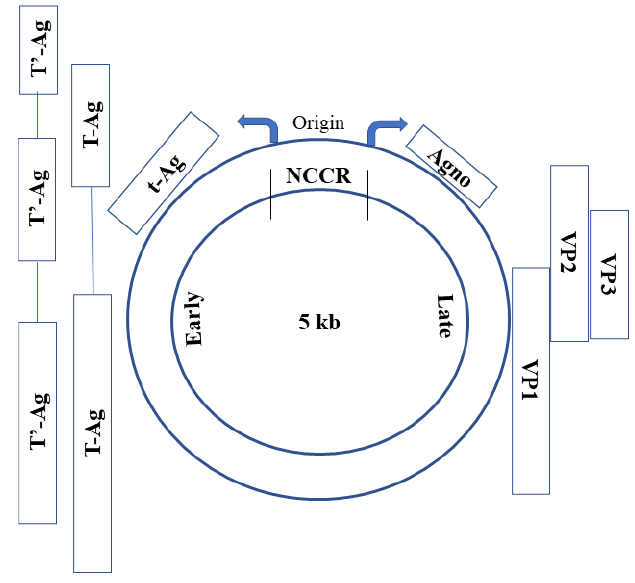
Figure 1. Graphical Sketch of BKV Genome. Early Genes Region: T-Ag (Large T antigen), T’-Ag (alternatively-spliced T-Ag), t-Ag (small T antigen); NCCR: Non-Coding Control Region; Late Genes Region: Agno (Agnoprotein), VP1–3 (viral capsid proteins).